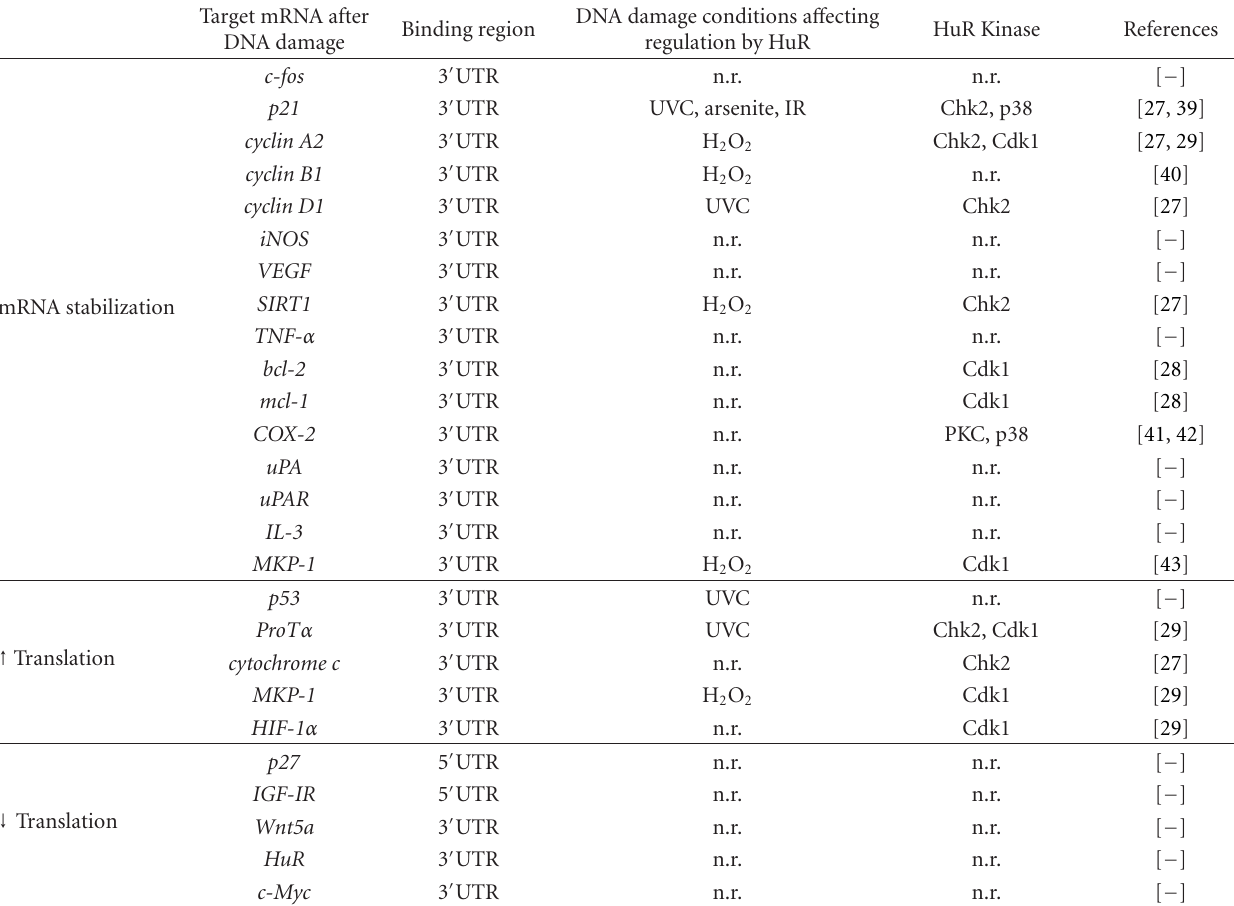
Table 1: HuR target mRNAs showing altered expression after DNA damage. Partial list of HuR target mRNAs encoding proteins that change following DNA damage (first column), the region of interaction with HuR (second column), and the genotoxic damage that was shown to a ff ect HuR regulation of the mRNA (third column); “n.r.”: no reported. The HuR kinases linked to the regulation of the mRNAs in the first column are indicated (fourth